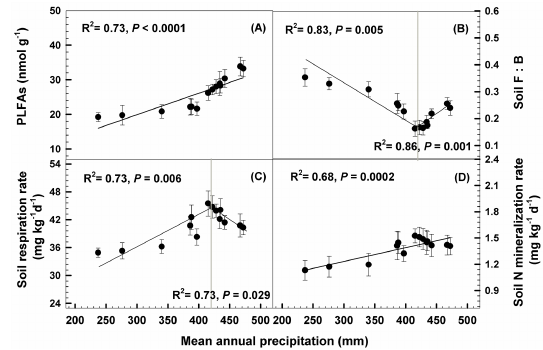
Figure 3. Patterns of soil microbial biomass (PLFAs) ( a ), soil fun- gal:bacterial biomass (F : B) ( b ), soil respiration rate ( c ) and soil net N mineralization rate ( d ) across the precipitation gradient in Leymus chinensis grasslands of northeastern